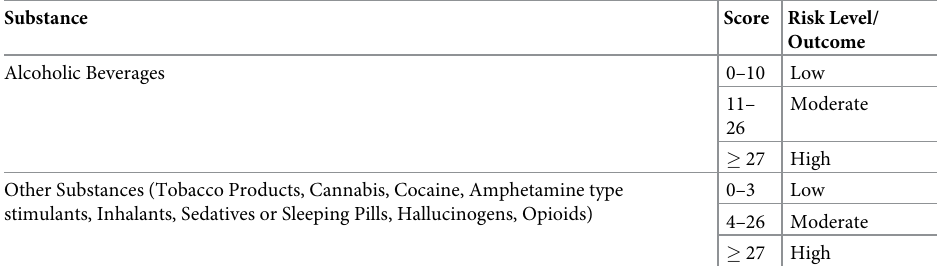
Table 1. ASSIST-defined substance use risk categories- specific substance involvement score